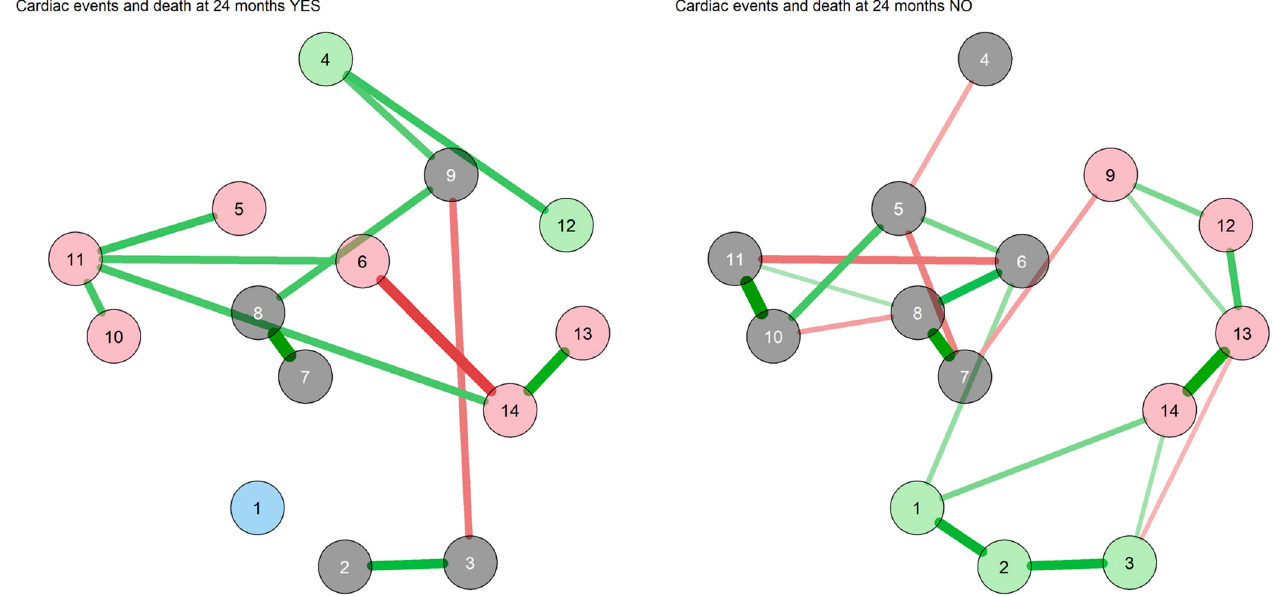
Figure 5. Network of trait measures with Bayesian estimation and walktrap community detection in the subgroups with and without MACE at follow-up. 1: TAS-20 Difficulty identifying feelings; 2: TAS-20 Difficulty describing feelings; 3: TAS-20 Externally oriented thinking; 4: TCI Novelty-seeking; 5: TCI Harm avoidance; 6: TCI Reward dependence; 7: TCI Self-directedness; 8: TCI Cooperativeness; 9: TCI Self-transcendence; 10: DS-14 Negative affectivity; 11: DS-14 Social inhibition; 12: DSQ-40 Mature defenses; 13: DSQ-40 Neurotic defenses; 14: DSQ-40 Immature defenses. Each node corresponds to a symptom cluster identified in the previous symptom reduction. Nodes are connected with lines (edges) that represent the strength of association between nodes. Green edges suggest positive associations, whereas red edges suggest negative associations. The thickness of the edge represents the edge’s weight, which is an indication of the strength of the association. The thicker the edge, the greater the weight and the stronger the association. In this network, all edges connecting the nodes are green (positive correlation), and their widths indicate the strength of their connections. Node colors indicate the community of the nodes. In the MACE YES network: grey for TCI characters, TAS DDF and TAS EOT; pink for immature defenses, harm avoidance and reward dependence and the DS-14; green for mature defenses and novelty-seeking; light blue for TAS DIF. In the MACE NO network: pink for defenses and the TCI Self-transcendence; green for the TAS; grey for the TCI personality traits and the